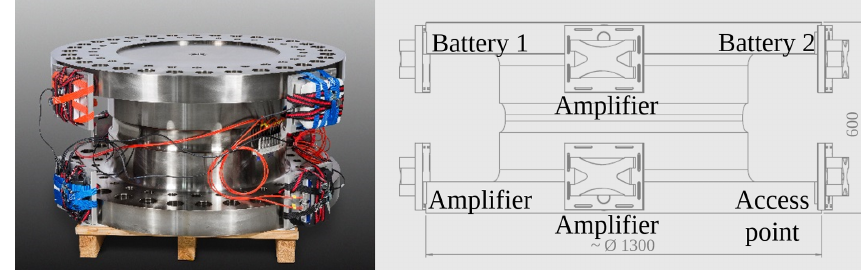
Figure 2. 5MNm TTS equipped with a self-sufficient DAQ, and a telemetry system to transmit the measurement data in